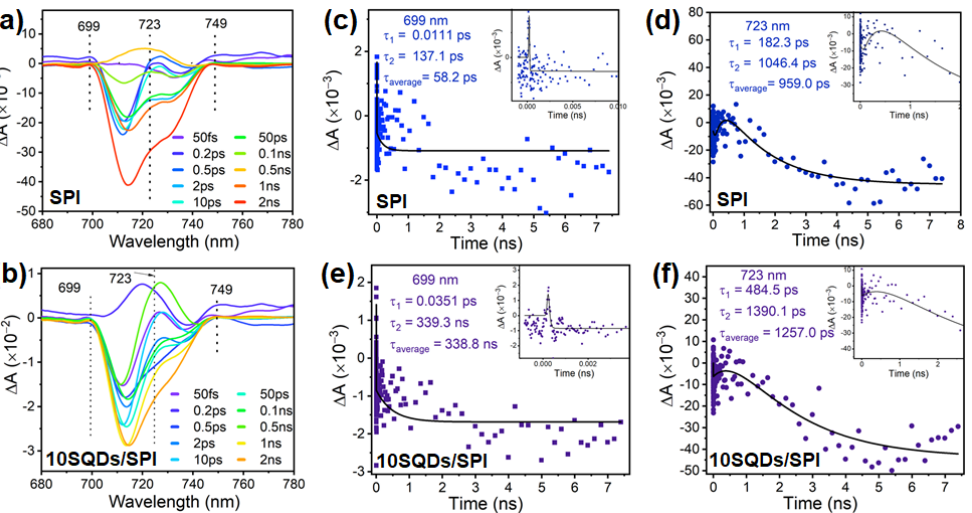
Figure 9. Ultrafast transient absorption spectra of ( a ) pure SPI and ( b ) 10SQDs/SPI; the transient decay kinetics of ( c , d ) SPI and ( e , f ) 10SQDs/SPI.